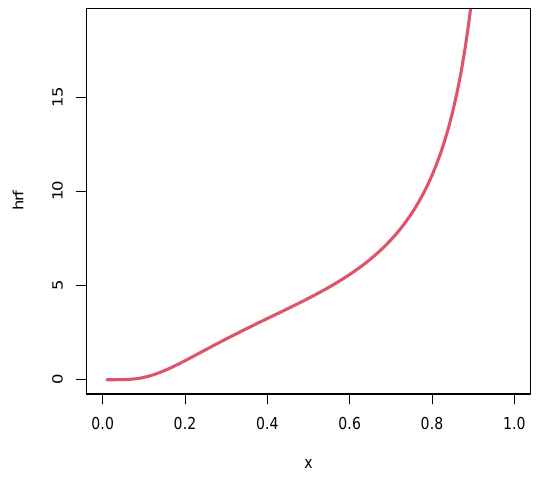
Figure 13. Plots of the estimated hrfs for the flood levels data